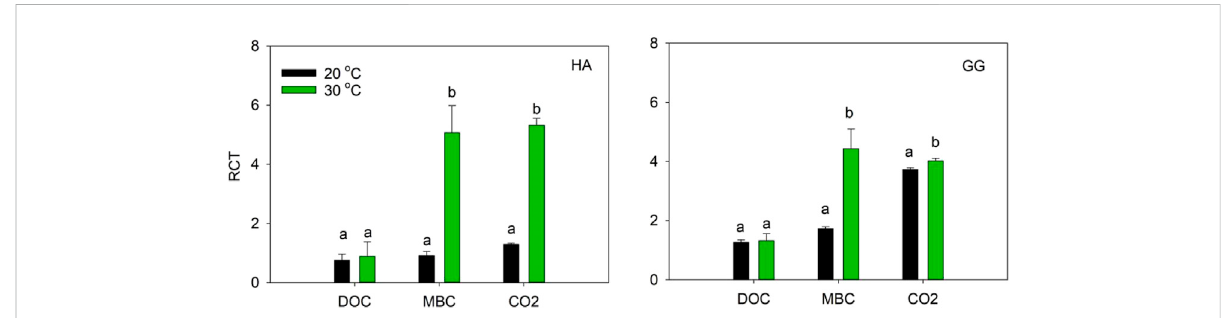
FIGURE 2 RCT variation after 1-year incubation at 20 C and 30 C. RCT is an indicator as the relative change of contribution of C 3 -C in DOC, MBC, and CO 2 -C increased while that of C 4 -C decreased during the incubation. Different lowercase letters denote signi fi cant differences at p < 0.05 level between 20 ° C and 30 C.